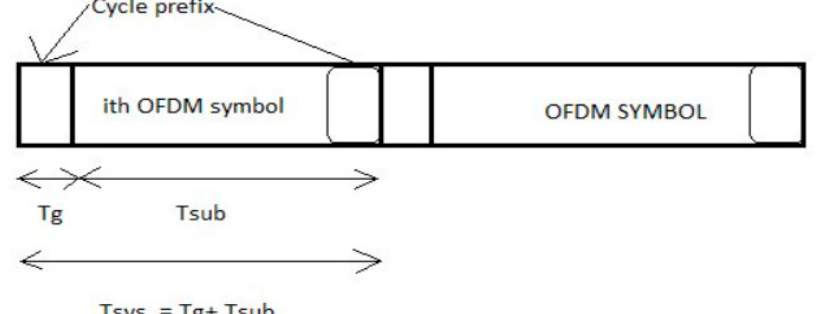
Figure 1. OFDM frame structure diagram. ( ) x t represents the OFDM symbol and ( ) u tion